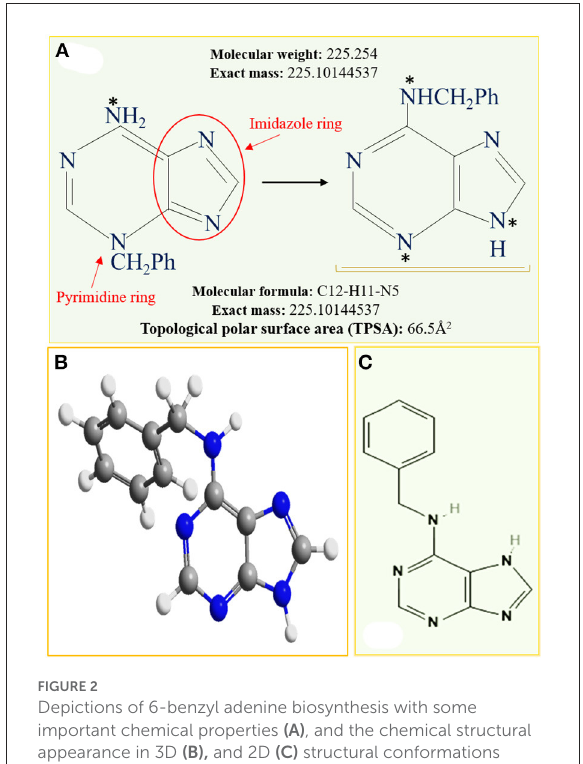
FIGURE2 Depictions of 6-benzyl adenine biosynthesis with some important chemical properties (A) , and the chemical structural appearance in 3D (B), and 2D (C) structural conformations (SpectraBase,